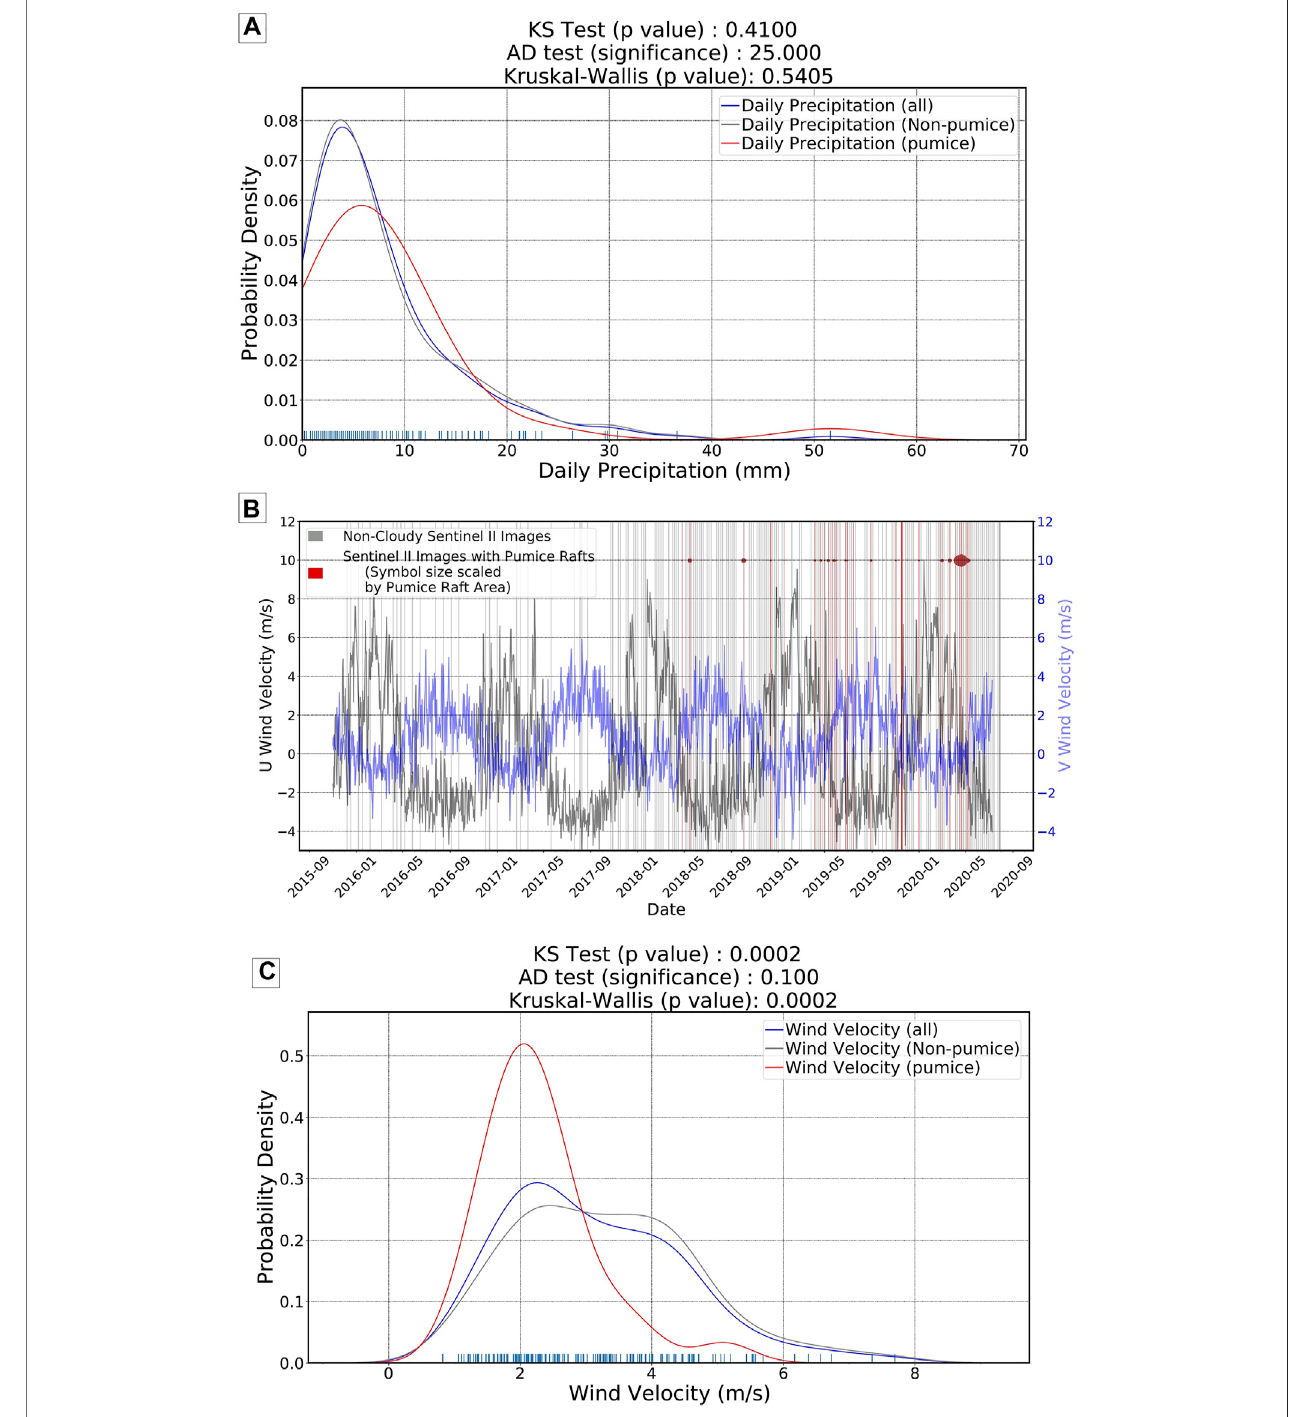
FIGURE 4 | (A) Probability density function for the daily precipitation in the Rabaul region (5 days rolling window) (B) Time series of daily wind directionality in the Rabaul region — U wind velocity is the eastward component of wind while the V wind velocity is the northward component (C) Probability density function for daily wind magnitude in the Rabaul region (5 days rolling window).